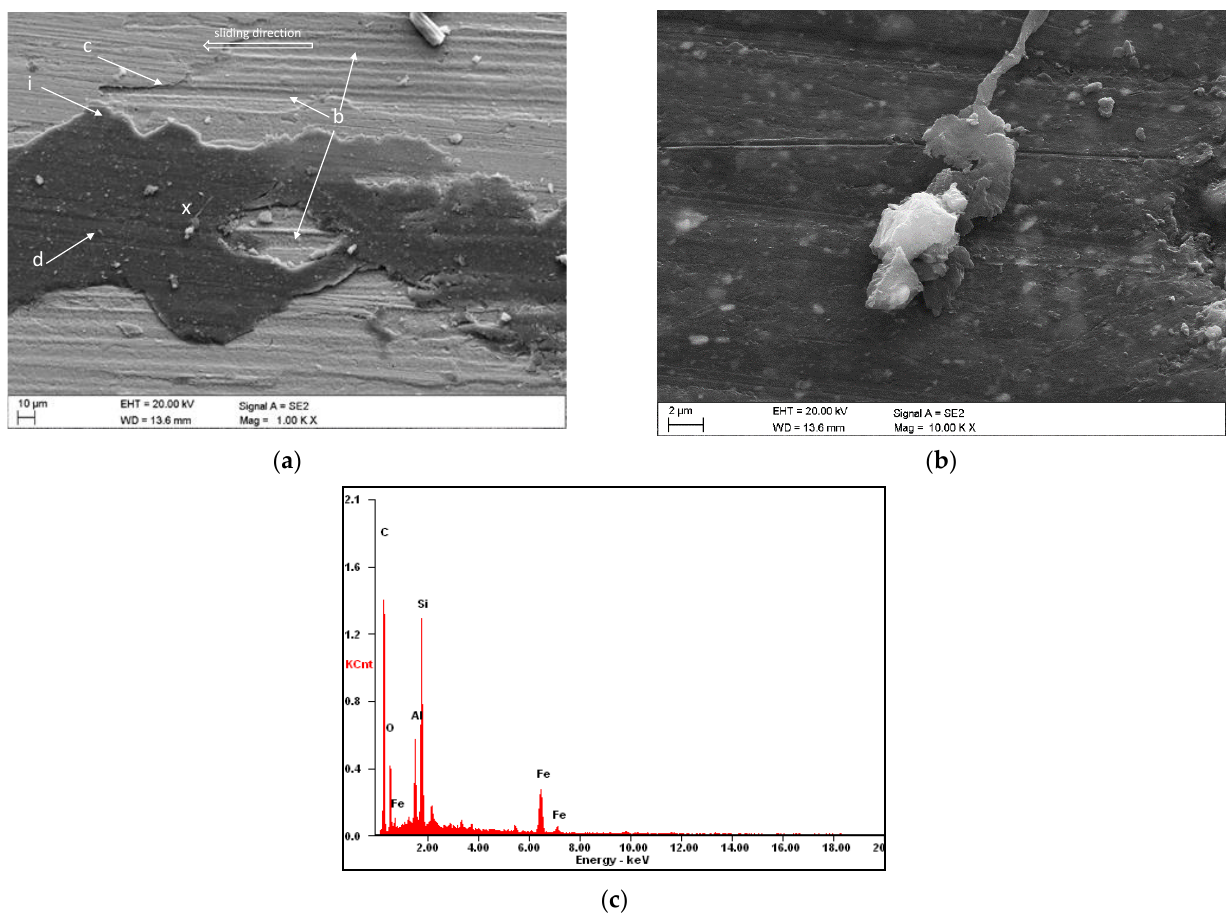
Figure 8. View of the coal layer pressed into the sample surface of WRS_400_I steel ( a ), the mixture of abrasive coal with crushed grains of minerals and wear debris ( b ) and EDS spectrum ( c ); symbols: b—plough, c—delamination, d—debris, i—coal layer; x—EDS analysis point.